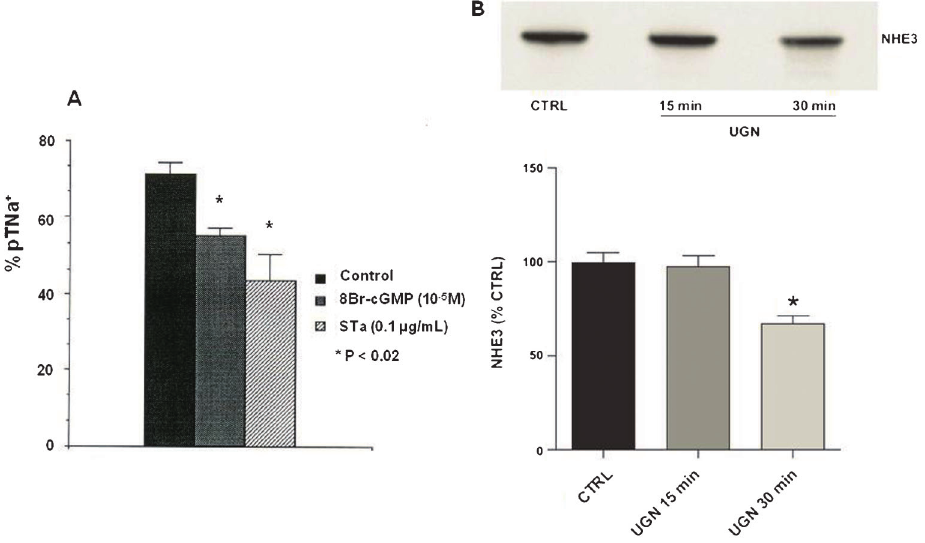
Figure 2. Effect of heat-stable enterotoxin (STa) from Escherichia coli and endogenous uroguanylin (UGN) mammalian peptide ligand of guanylyl cyclase C on net sodium balance in the kidney. Panel A shows the decreased effect of STa and 8Br-cGMP on proximal sodium tubule transport (pTNa + ) in isolated perfused rat kidney (reproduced from Ref. 4, with permission). Panel B also shows the reduced effect of UGN on sodium proton transporter NHE3 in renal proximal tubules, as well as the surface NHE3 expression in proximal tubule cells in culture (reproduced from Ref. 69, with permission). CTRL: control. *P , 0.05, compared to UGN 15 min and control (Bonferoni